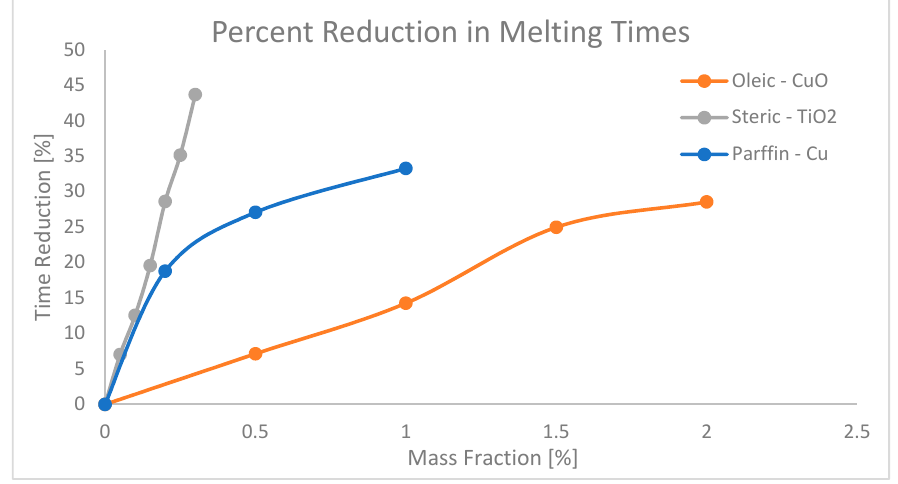
Figure 11. Percent reductions in melting times of paraffin, oleic and steric acids from references [27,51,52].